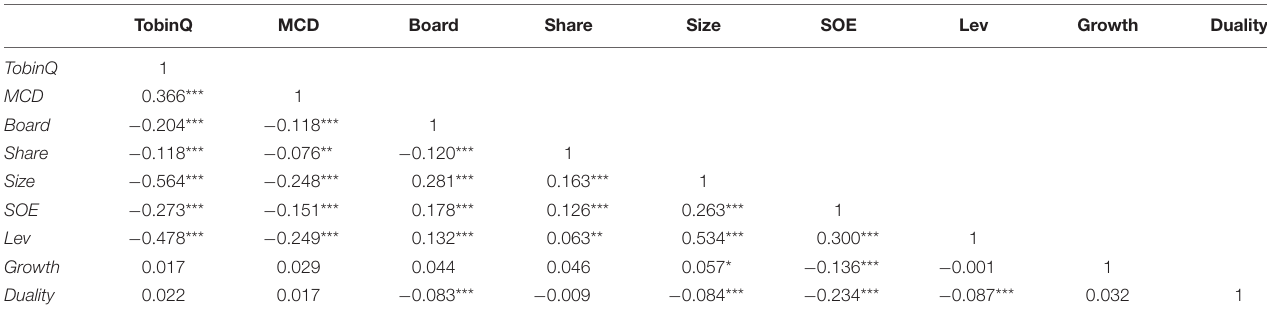
TABLE 4 | Results for pair-wise correlation analysis.